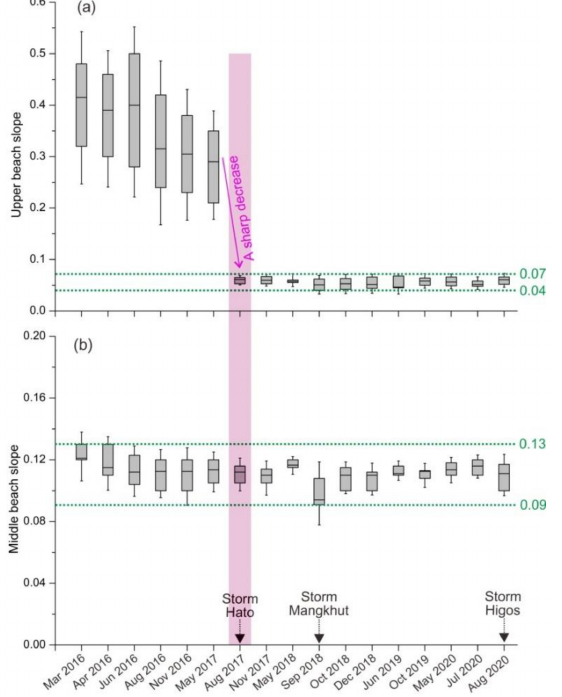
Figure 9. Temporal evolution of upper ( a ) and middle beach slopes ( b ) along ML beach during the study period. Pink band highlights the period when a sharp decrease in the upper beach slope occurs. Note that the horizontal axis shows irregular intervals between two successive surveys.